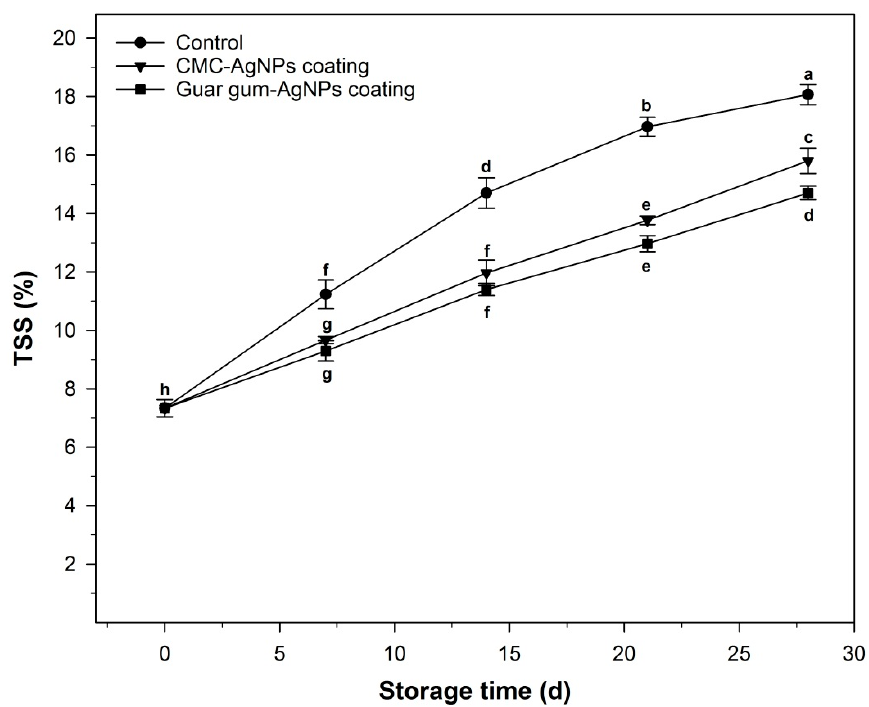
Figure 8. Effect of CMC-AgNP and guar gum-AgNP coatings on total soluble solids (TSS) of “Seddik” mango fruits stored at 13 °C for 4 weeks. Vertical bars represent the SE of means. Means with the same letter are not significantly different according to Duncan’s multiple range test ( α ≤ 0.05).